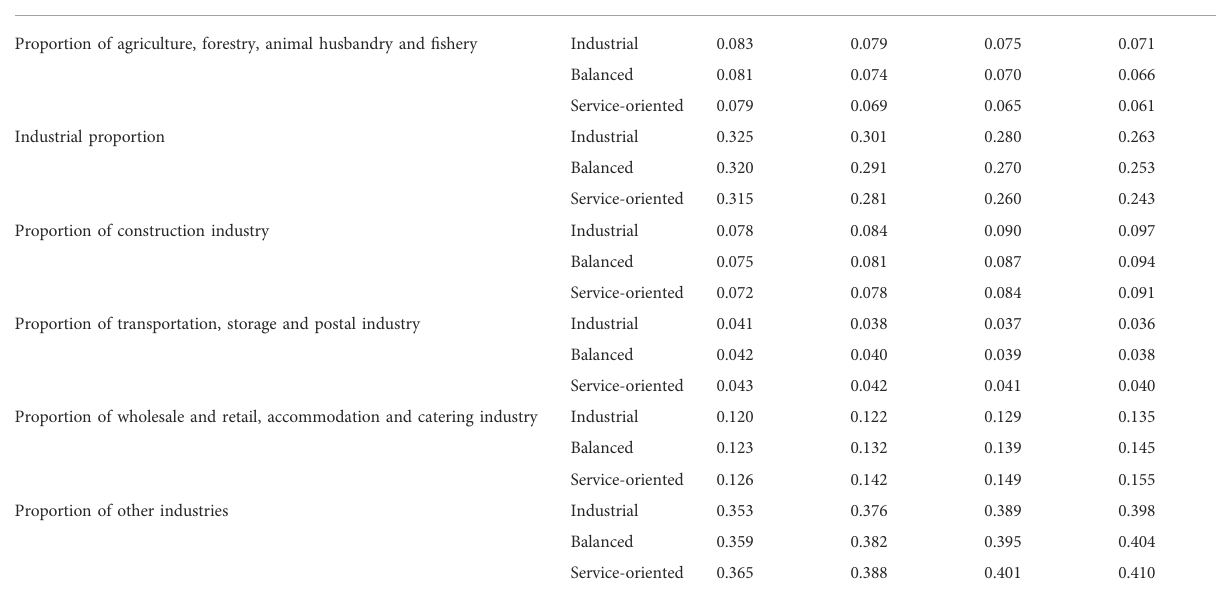
TABLE 7 Industrial structure setting under different scenarios.